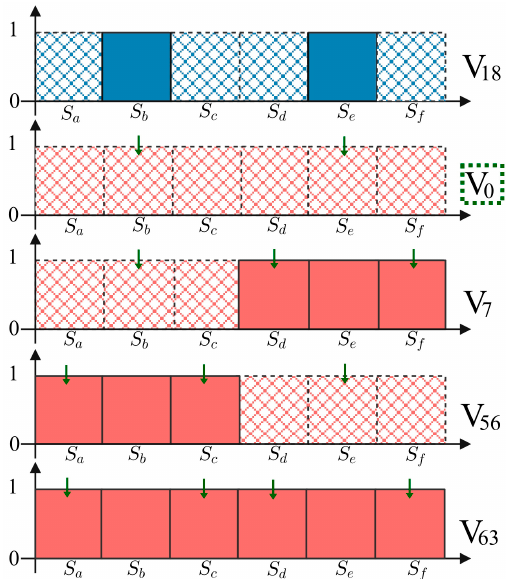
Figure 5. Memory stage: selecting the best null voltage vector.